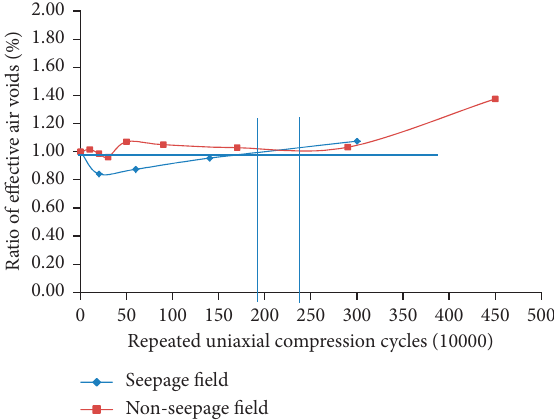
Figure 14: Relationship between repeated uniaxial compression cycles and ratio of effective air voids.